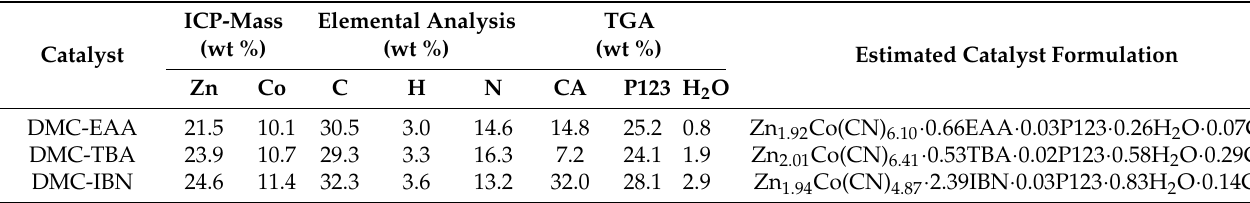
Table 1. Elemental analysis of the DMC catalysts.